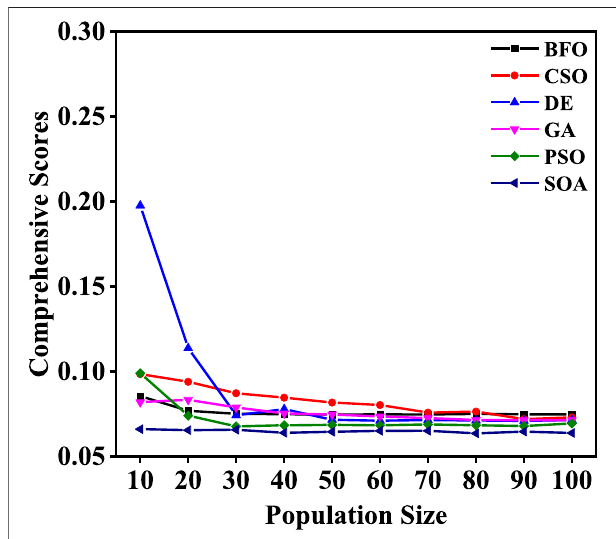
FIGURE 4 | Comprehensive scores of different BIOs for all source parameters (Q 0 , x 0 , y 0 , z 0 ) under different tested population sizes.